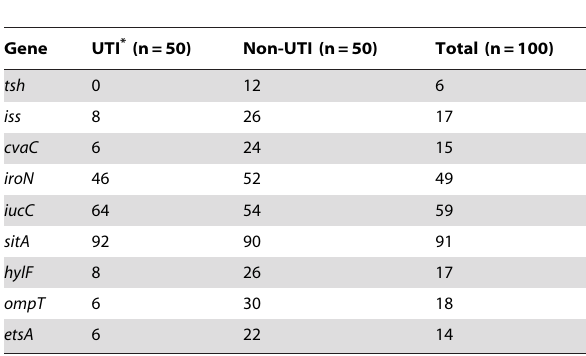
Table 2. Prevalence (%) of pAPEC-1 virulence-associated genes in human